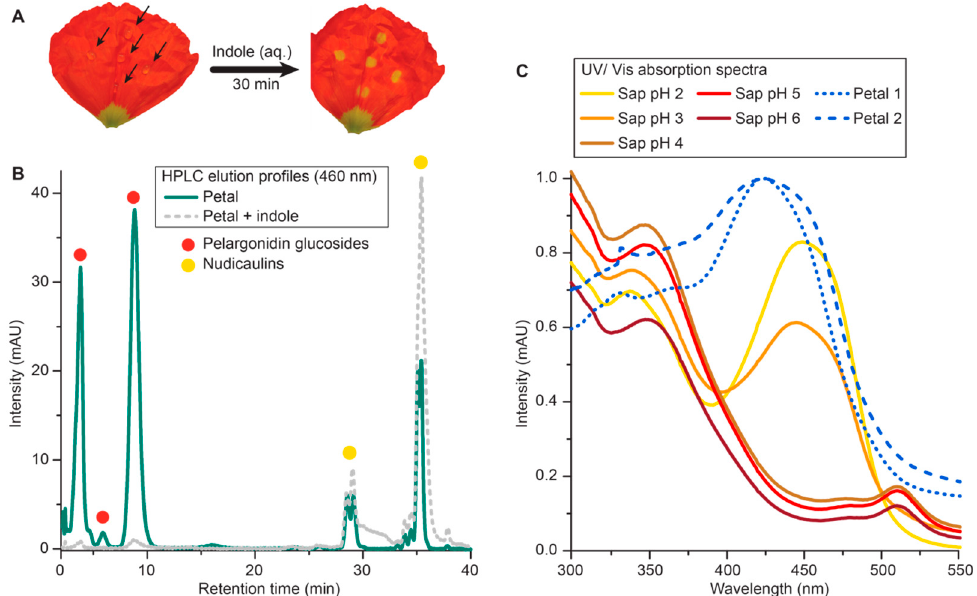
Figure 2. ( A ) In vivo formation of nudicaulins: Drops of aqueous indole solution (1 mg·mL − 1 ) were applied to a petal of the orange P. nudicaule cultivar. After 30 min, the color of the treated petal area changed to yellow. ( B ) HPLC elution profile (460 nm, HPLC 1, method 1) of a petal extract of the orange P. nudicaule cultivar (dark green line) compared with the elution profile of an extract of a petal which had been immersed in indole solution for 20 min (gray line). Pelargonidin glucosides were transformed into nudicaulins during treatment with indole solution. ( C ) UV/Vis absorption spectra of the cell sap of yellow P. nudicaule petals at different pH values (solid lines) in comparison with the spectra of intact petals (dotted lines). The typical absorption in the spectral region around 450 nm which accounts for the yellow color is present only in strongly acidic cell sap.